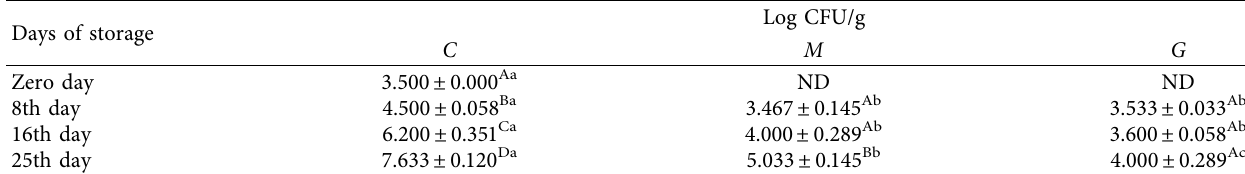
Table 3: The psychrophilic bacterial count (log CFU/g) in treated catfish fillet groups with LSSM ( M ) and LSSM-Se NPs ( G ) compared to control ( C ) after storage at refrigeration temperature ∗ .